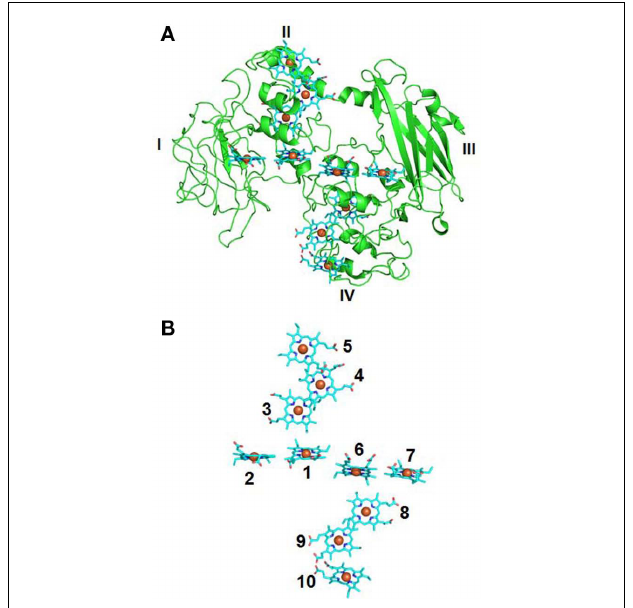
FIGURE 2 | Molecular structure of MtrF of S. oneidensis MR-1. (A) Crystal structure of MtrF (PDB-ID: 3PMQ) showing the peptide chain (green) and hemes (Blue). Domains I–IV are labeled. (B) Arrangement of MtrF hemes shown in the same orientation as panel (A) .The hemes are numbered according to the position of their corresponding CXXCH binding motif in the MtrF amino acid